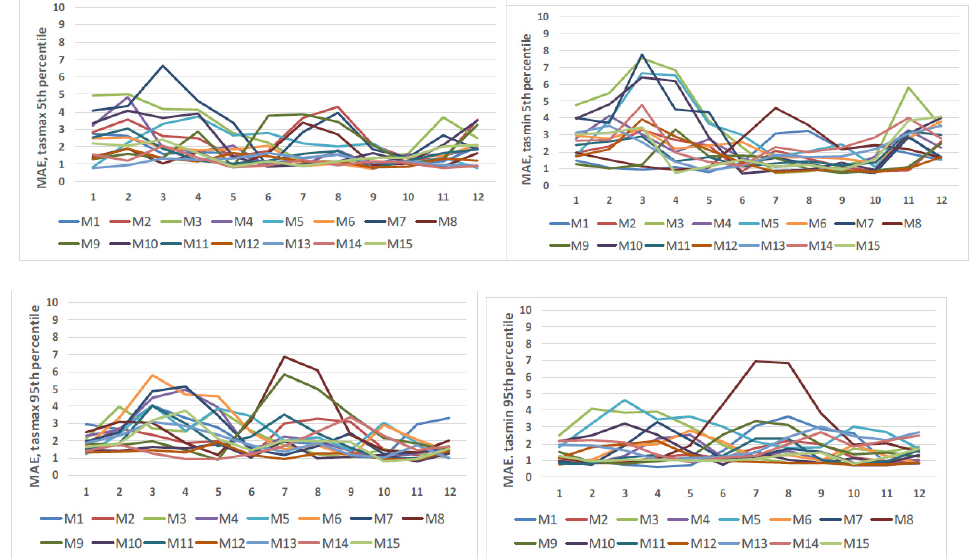
Figure 4. Mean absolute error (MAE) for the 5th and 95th percentiles in case of daily tasmax and tasmin, EURO-CORDEX simulations (full names of individual models are given in Table 1) against ROCADA observation-derived datasets, over the period 1971–2000. The spatial correlation was determined between modeled and observation-derived gridded values. Figure 5 presents the correlation coefficients over the 12 months for tas- min (left) and tasmax (right). A strong correlation was detected for annual mean values for both parameters (Table 2), but during the summer, three models revealed a weak cor- relation in tasmin (M9, M2, and M7). Figure 5. Pearson correlation for tasmin ( left ) and tasmax ( right ) between EURO-CORDEX simula- tions (full names of individual models are given in Table 1) and ROCADA observation-derived da- tasets over the period 1971–2000. In general, all the 15 RCMs can represent these variables within a reasonable range of uncertainty (Table S1). For tasmax, the MAE is between 0.7–5.3 °C having a median of 1.6 °C. More significant errors (higher than 4 °C) are present in March–April and July– August. Regarding tasmin, the range of MAE is 0.6–5.4 °C with a median value of 1.5 °C. Larger errors (more than 4 °C) are present in February–April and July–August. The most extensive spread of errors was found for precipitation, where the MAE range of monthly precipitation is 6.2–59.4 mm with a median of 19.6 mm. Higher errors (more than 40 mm) were detected for May–August. The spatial representation of the variables was checked by a spatial correlation between model outputs and observations. The maximum temper- ature is represented very well. The median of the correlation coefficient throughout the